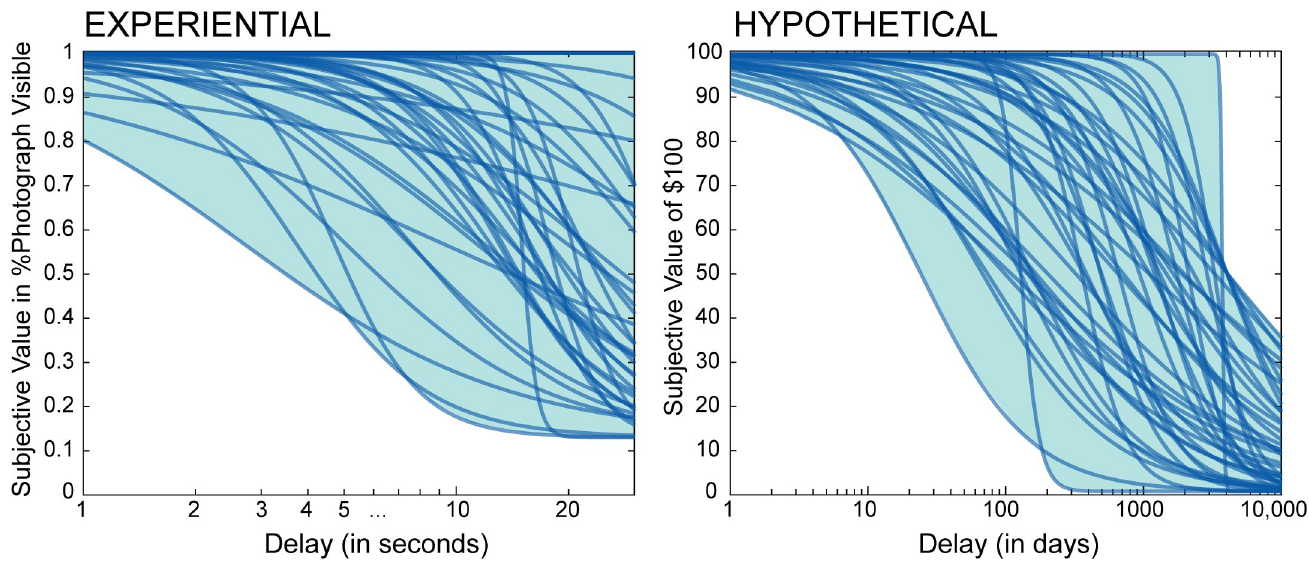
Fig 6. Logistic temporal discounting curves. Logistic temporal discounting curves resulting from fitting indifference point data for the experiential (left) and hypothetical (right) intertemporal choice tasks. Temporal discounting curves are depicted for each participant and each task. Delays are presented using logarithmic